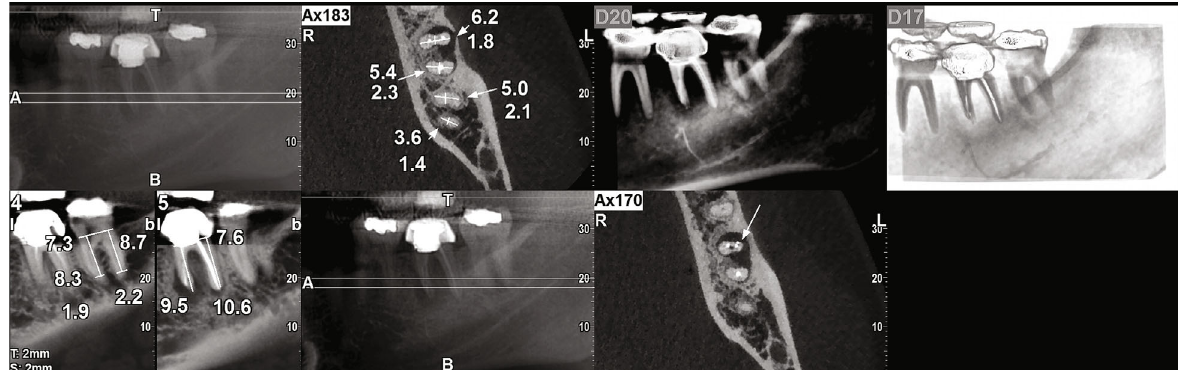
Figure 2: Cone-beam computed tomography (CBCT) showed large periradicular radiolucency around the mesial root in tooth #18, with sizable bone loss/resorption and the furcation